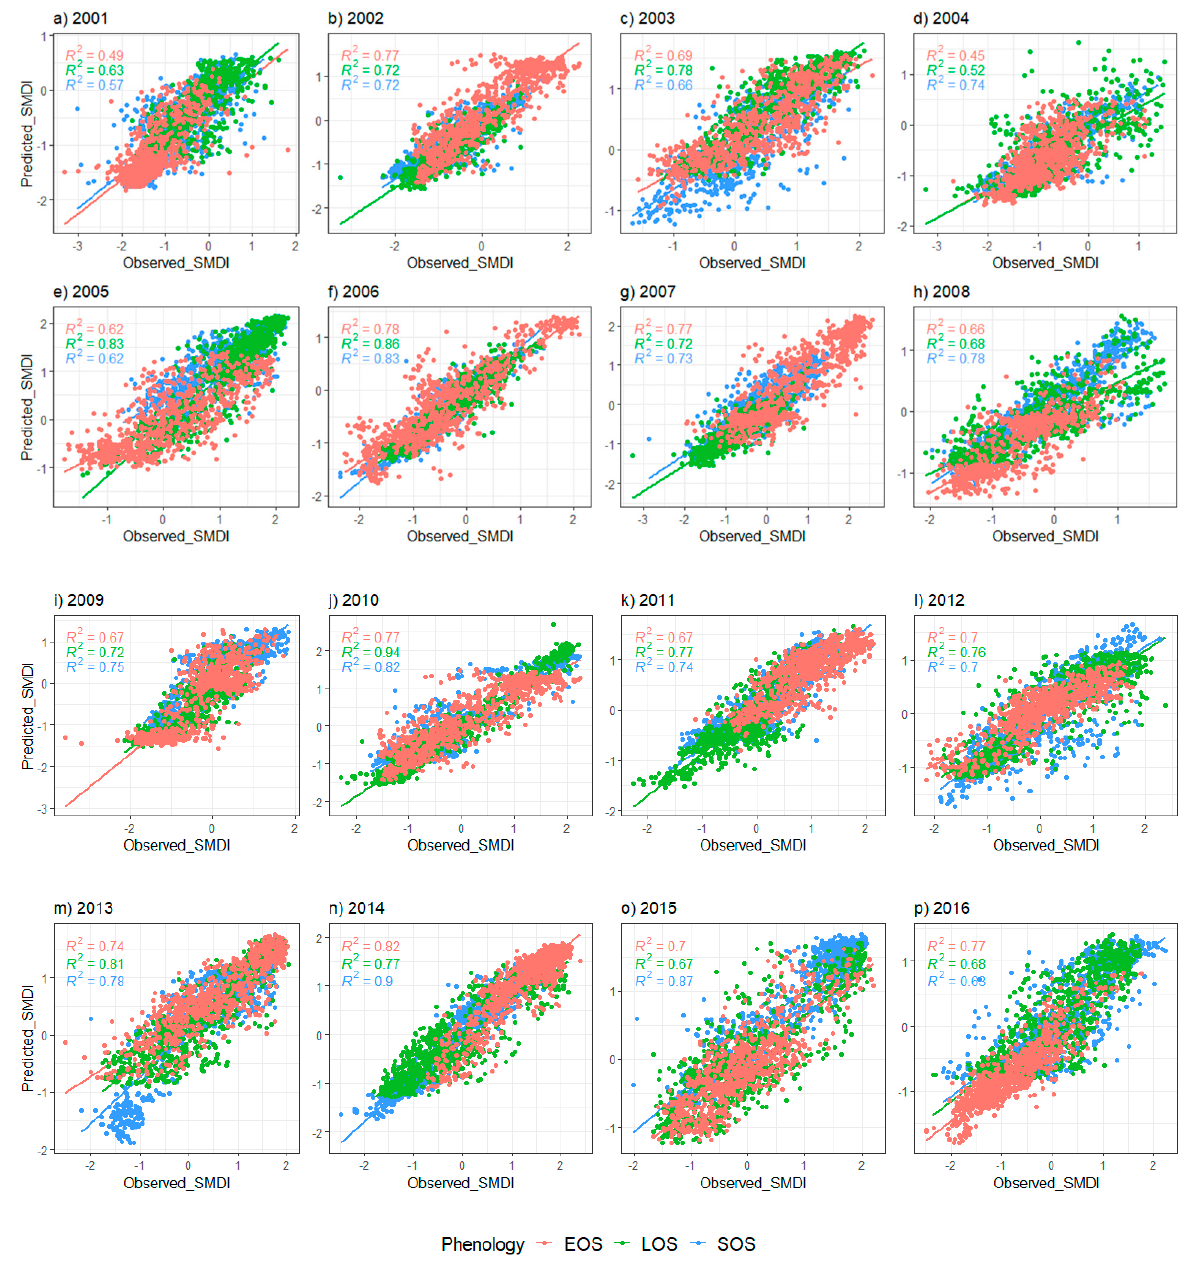
Figure 13. Scatterplot between observed SMDI and predicted SMDI during SOS, EOS, and LOS from 2001–2016. Further, we investigated how much each input variable stimulates the SMDI distribution over South Asia by exploring the variable importance feature to the input function of the deep learning model. Results presented in Table 6 suggested that precipitation factors were the most important factors, contributing significantly to SMDI during the three phenology stages. In addition, among the precipitation factors SPI-6 had the highest contribution effects on SMDI variability simulated by the DFNN model.